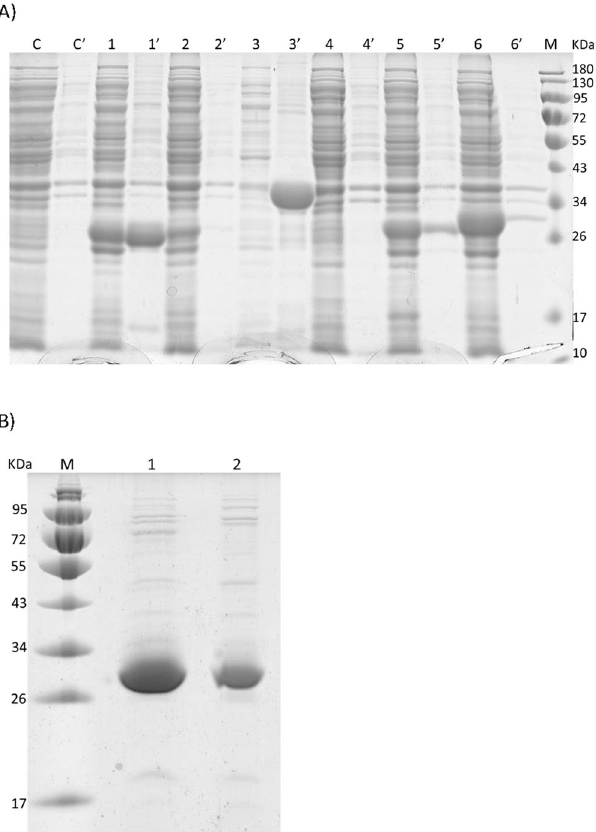
Figure 1. SDS-PAGE results of aspartate dehydrogenase expression and purification. ( A ) SDS-PAGE results of protein expression. M: molecular mass markers; Lane 1–6 and 1 ′ –6 ′ represent the soluble and insoluble fractions of empty vector pED31, KpnAspDH, DelAspDH, MplAspDH, RedAspDH, ReuAspDH and BjaAspDH, respectively. ( B ) Purification of recombinant KpnAspDH and DelAspDH. M: molecular mass markers; Lane 1: KpnAspDH; Lane 2: